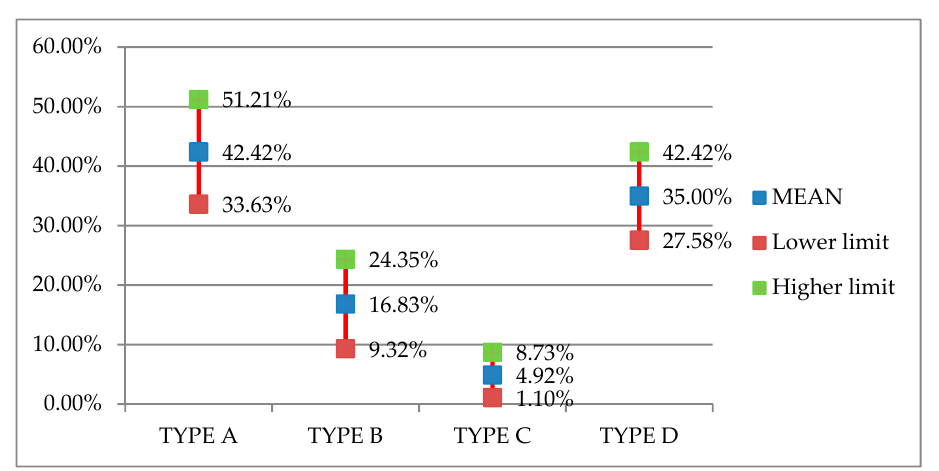
Figure 7. Estimated percentage use of scaffolding types in Spain.